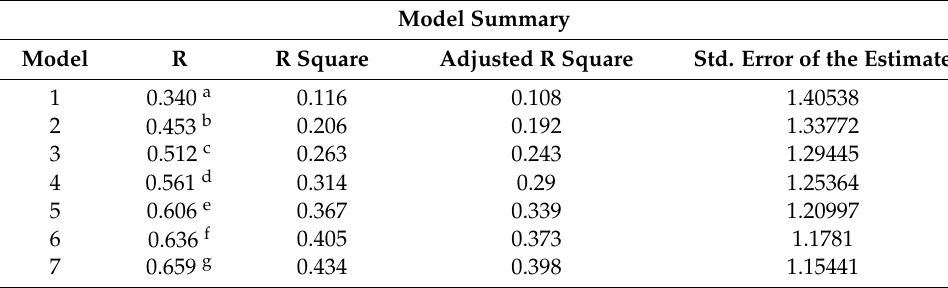
Table 4. The analysis of seven model